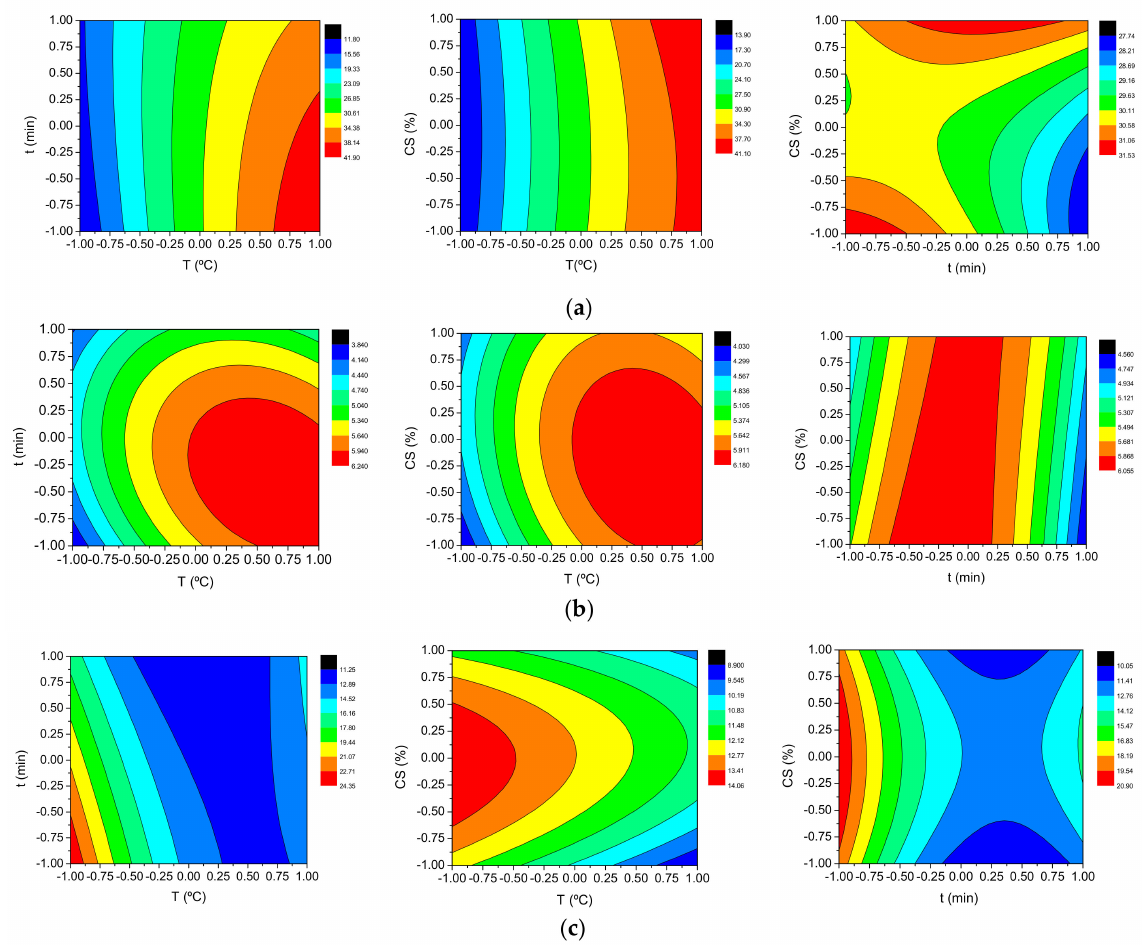
Figure 1. Contour graphs for the thermal HTL process carried out with N. gaditana biomass. ( a ) biocrude yield (%), ( b ) nitrogen content (wt%) in the biocrude, and ( c ) oxygen content (wt%) in the biocrude. Fixed variable in the central point: T = 260 ◦ C, t = 10 min, CS = 30